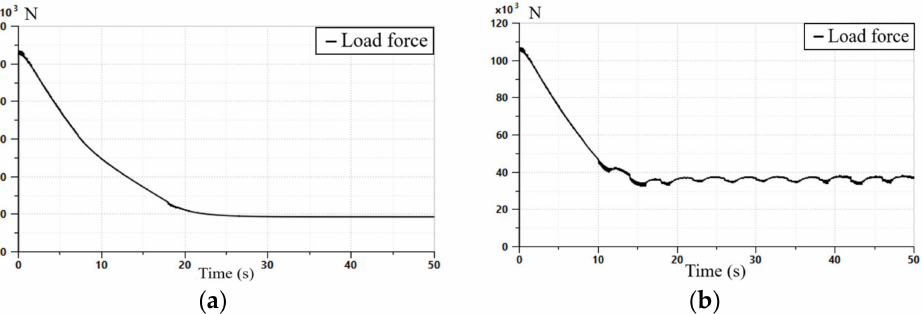
Figure 15. ( a ) erect load force curves impact lateral force; ( b ) erect load force curves periodic lateral